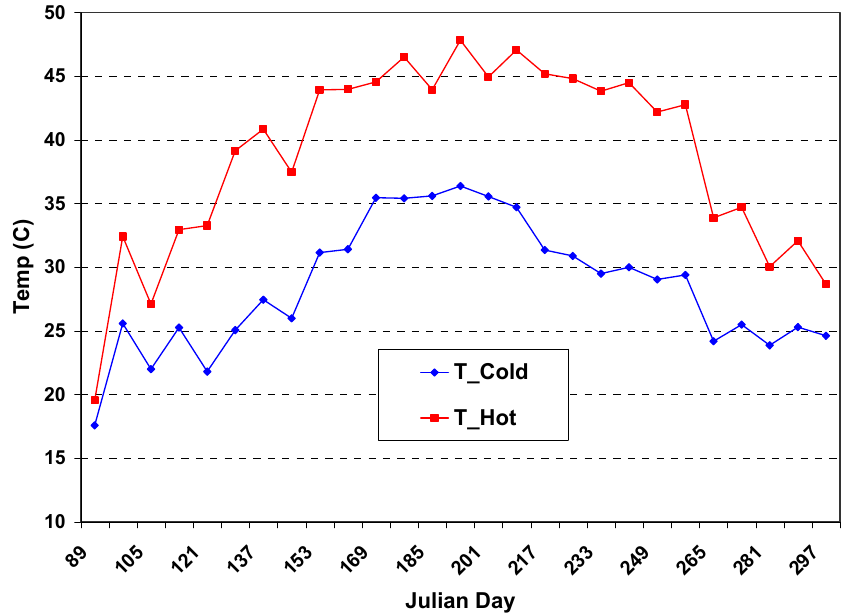
Figure 6. Temporal variation of the hot (T_hot) and cold (T_cold) pixel values during the 2003 crop growing season in o